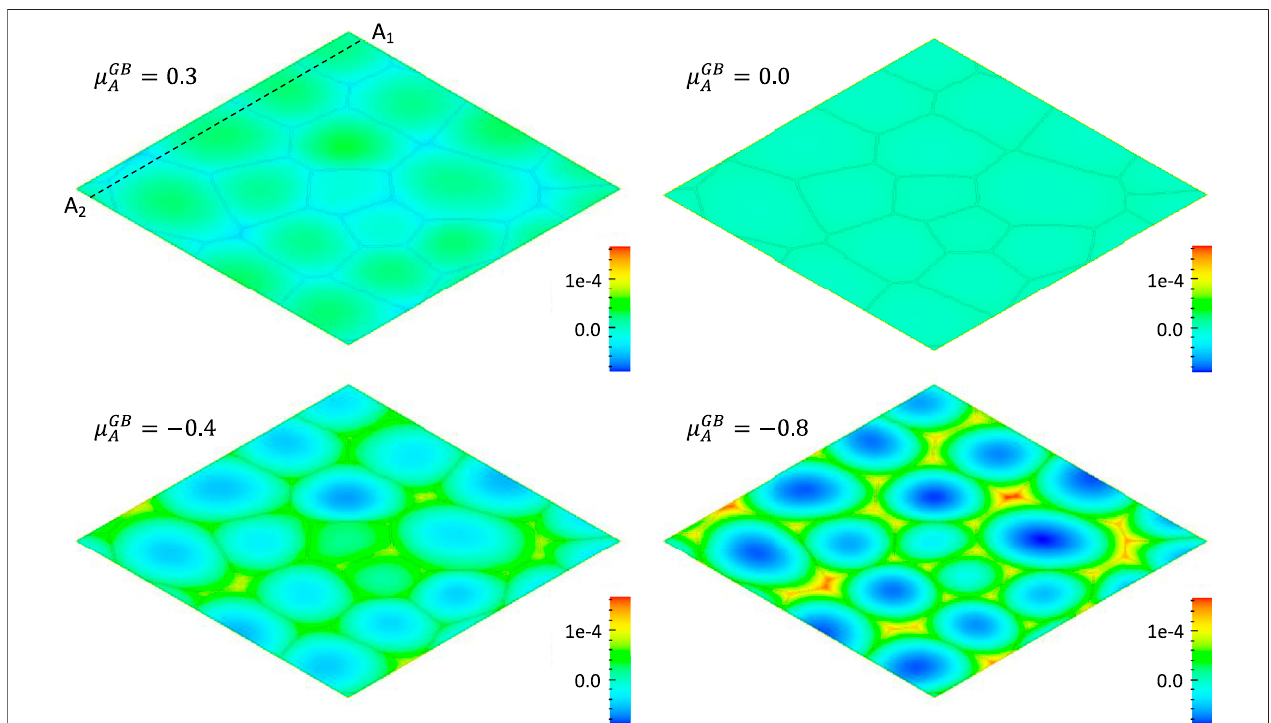
FIGURE 2 | Effect of chemical potential μ GB A on the distribution of the solute A concentration change Δ c A . μ GB A has the unit of [eV/atom].